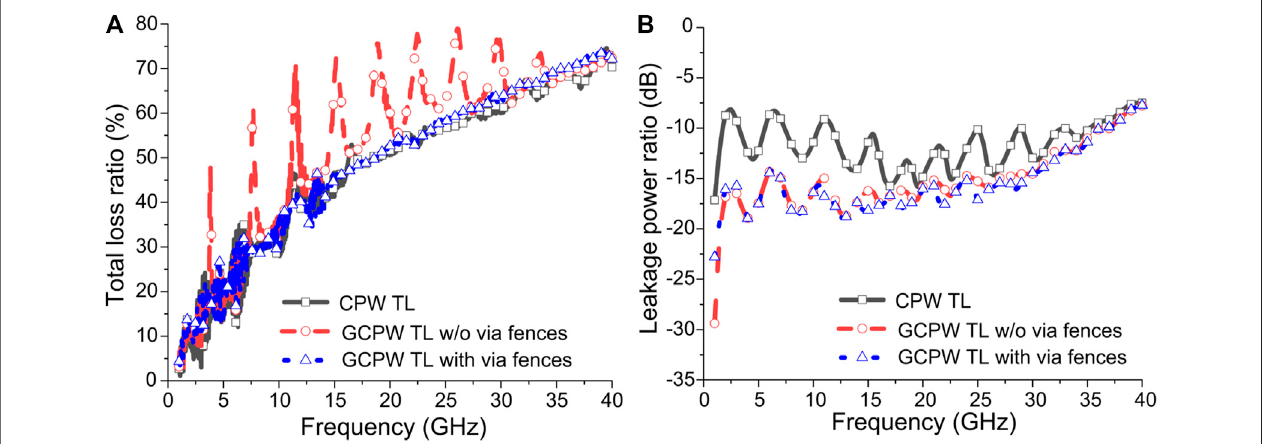
FIGURE 3 | L (cid:2) 20 mm. (A) Measured total loss ratio. (B) Simulated leakage power ratio.